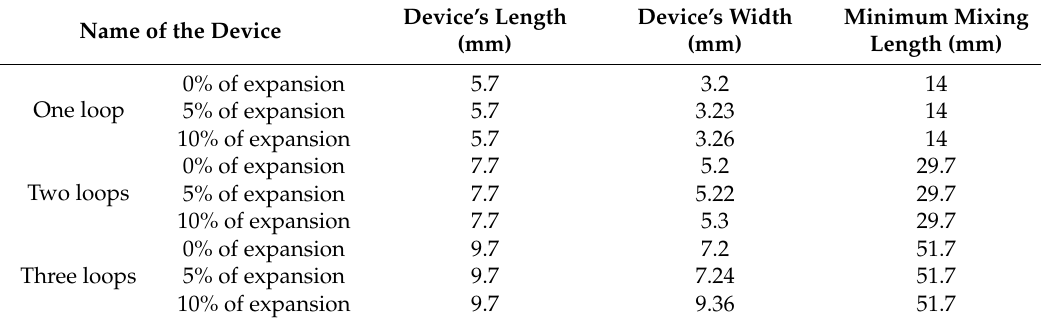
Table 1. Overall dimensions of the studied models. The height of the channel at all sections is constant and set to 20 µ